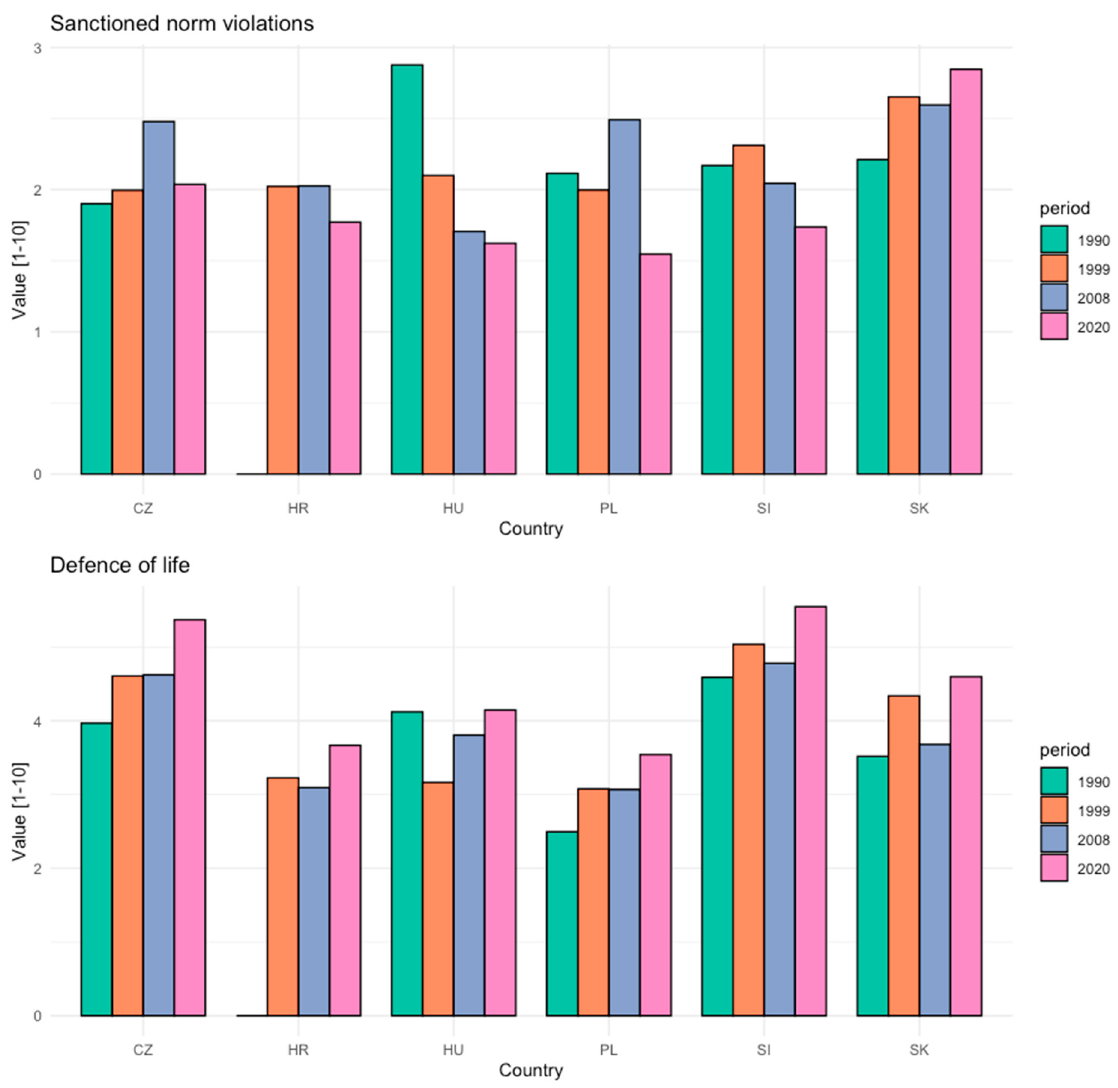
Figure A2. Sanctioned norm violations and defence of life indices (EVS).